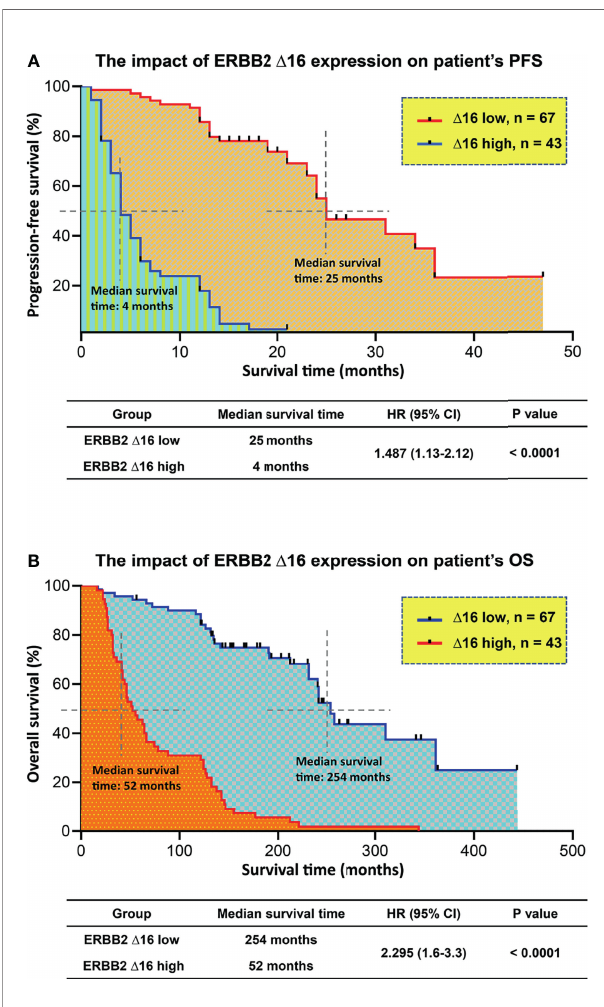
FIGURE 5 | Unfavorite prognosis in patients with high ERBB2d16 expression. (A, B) Kaplan – Meier plotting of PFS (A) and OS (B) for patients strati fi ed by ERBB2d16 expression who had been treated with chemotherapy plus trastuzumab (n = 110). D 16 low: ERBB2d16/ERBB2 ratio < 0.88; D 16 high: ERBB2d16/ERBB2 ratio ≥ 0.88. PFS; progression free survival; OS: overall survival; HR: hazard ratio; ERBB2: human epidermal growth factor receptor-2; ERBB2d16: ERBB2 D Ex16 .